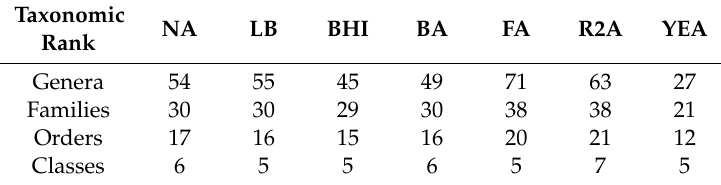
Table 1. Number of bacterial taxa recovered on each growth